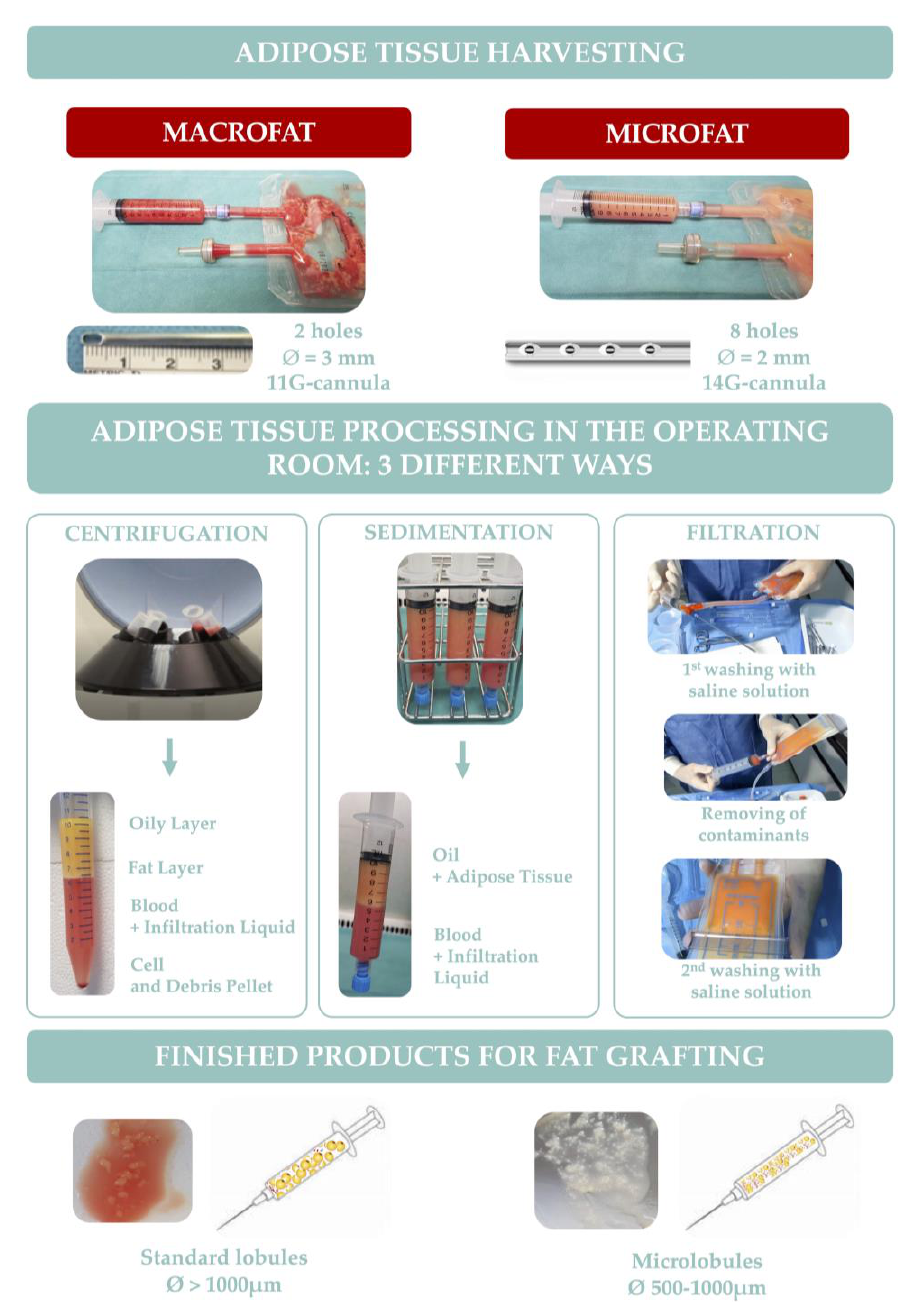
Figure 2. Harvesting, processing and characteristics of macrofat and microfat.